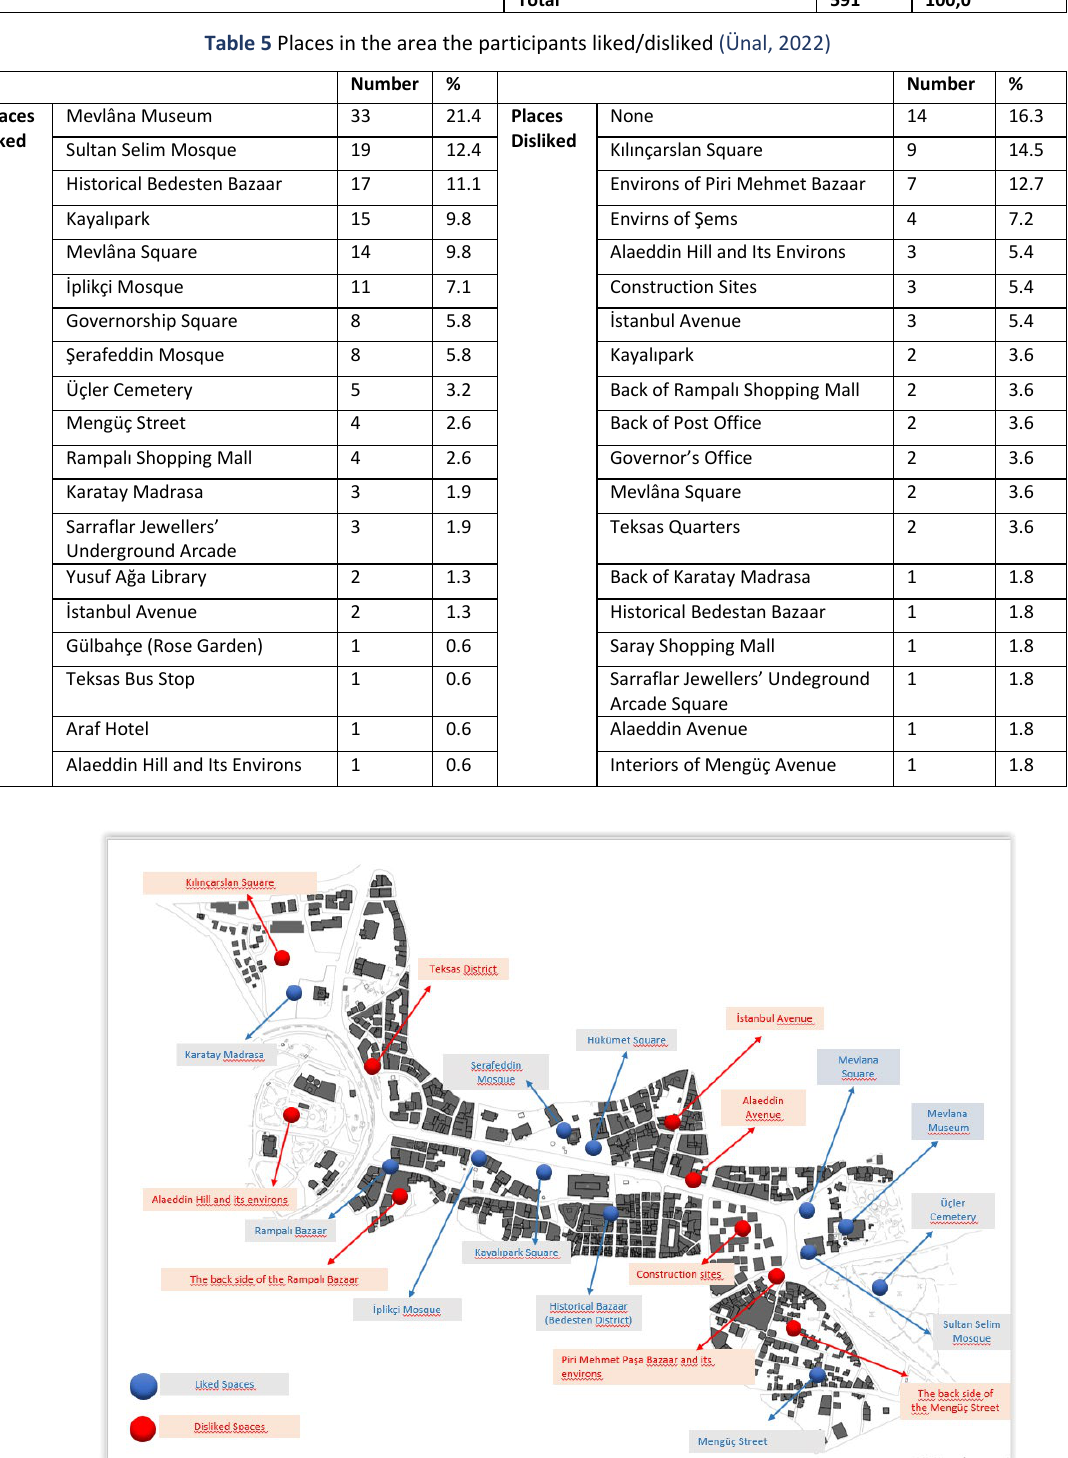
Figure 15 Places that the participants like/dislike in the case area (Ünal,